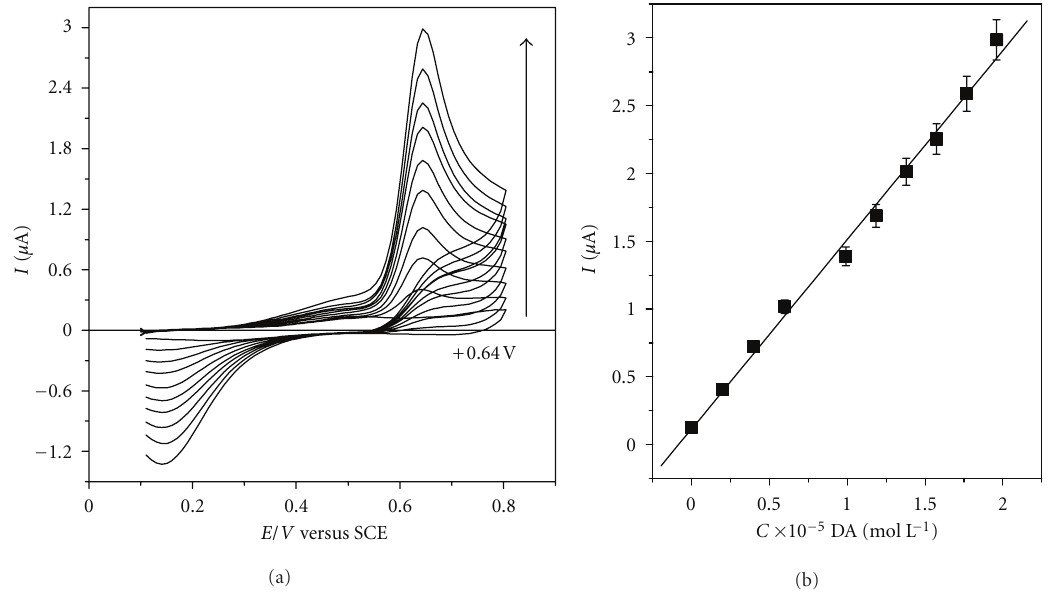
Figure 5: Dopamine detection test: (a) cyclic voltammograms for DA detection at concentrations ranging from 0 to 1.96 × 10 − 5 molL − 1 , in H 2 SO 4 0.05mol L − 1 at 25 mVs − 1 , for ITO/(DS 01/NiTsPc) 3 film. (b) Calibration curve ( I versus C ) for DA detection.